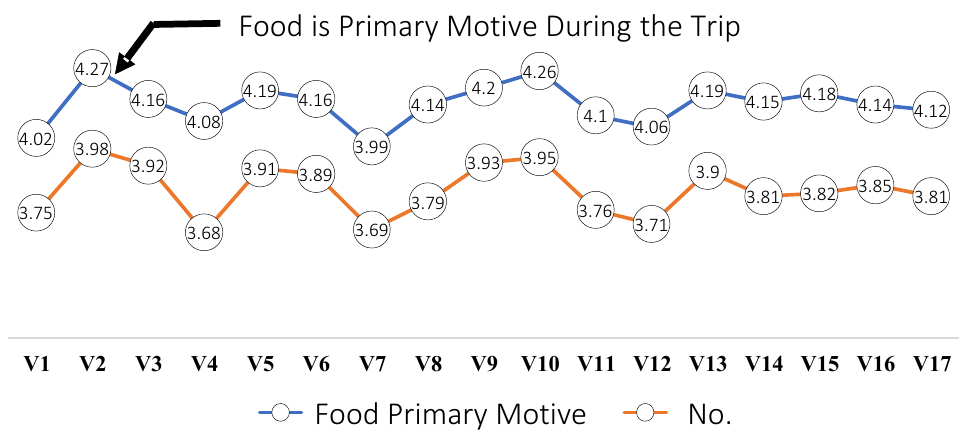
Figure 5. Comparing tourists with food as a primary motive or otherwise